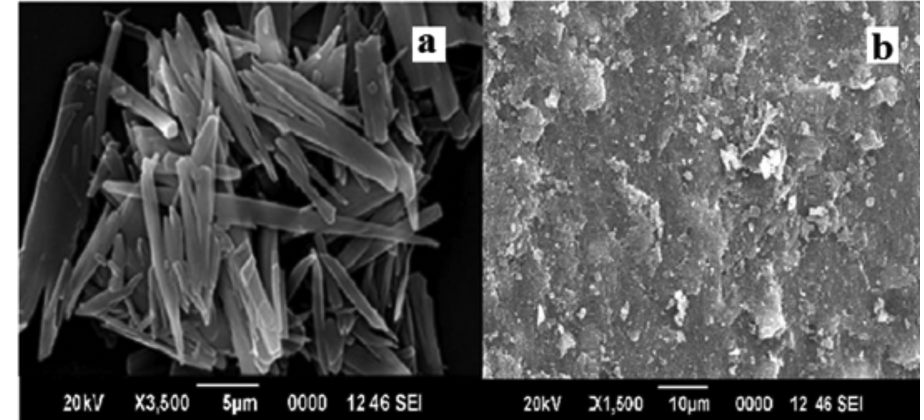
FIGURE 6 - Scanning electron microscopy photographs of ( a ) Raloxifene HCl and ( b ) Solid dispersions prepared by microwave induced fusion method with an exposure time of 6 min.